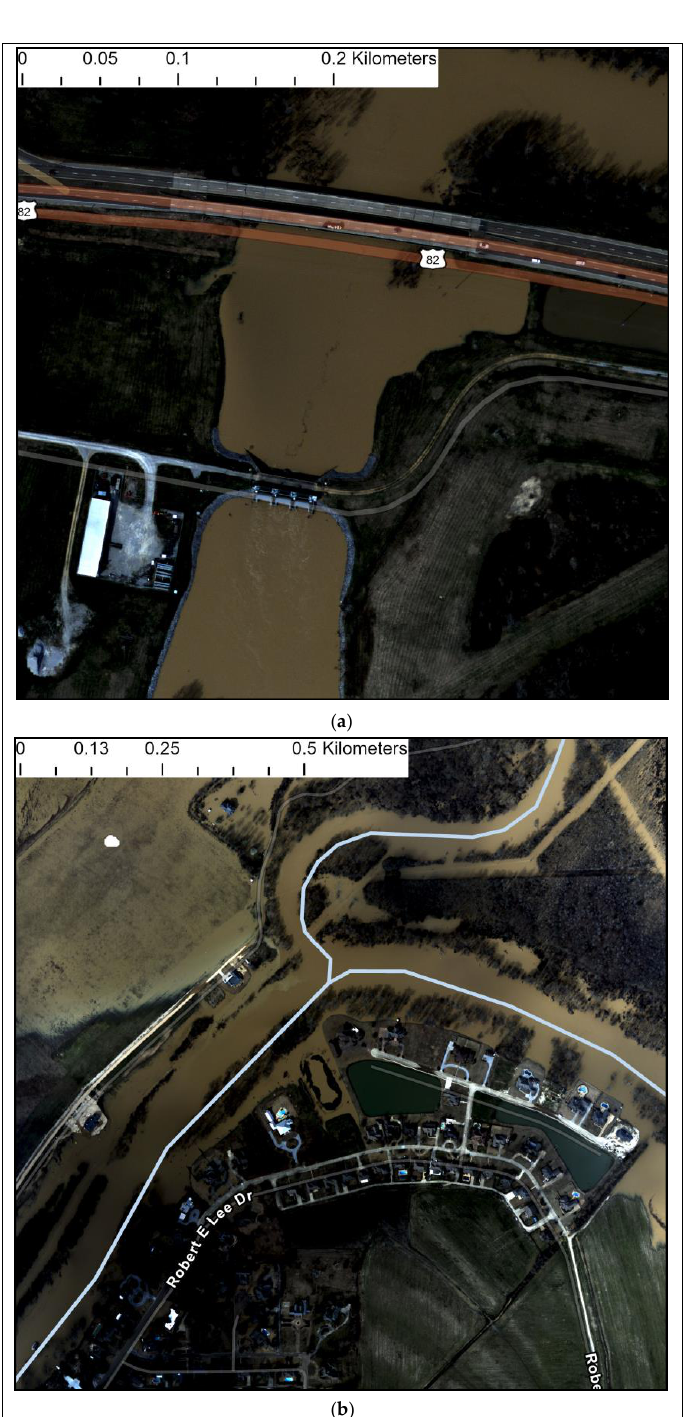
Figure 7. UAS-collected RGB imagery showing flood conditions from Feb. 25, 2019 flight ( a ) near a dam along Hwy. 82 west of Greenwood, MS, and ( b ) the confluence of the Yalobusha and Little Tallahatchie Rivers (which marks the beginning of the Tallahatchie River). Blue lines denote water flowlines defined by the National Hydrography Dataset.